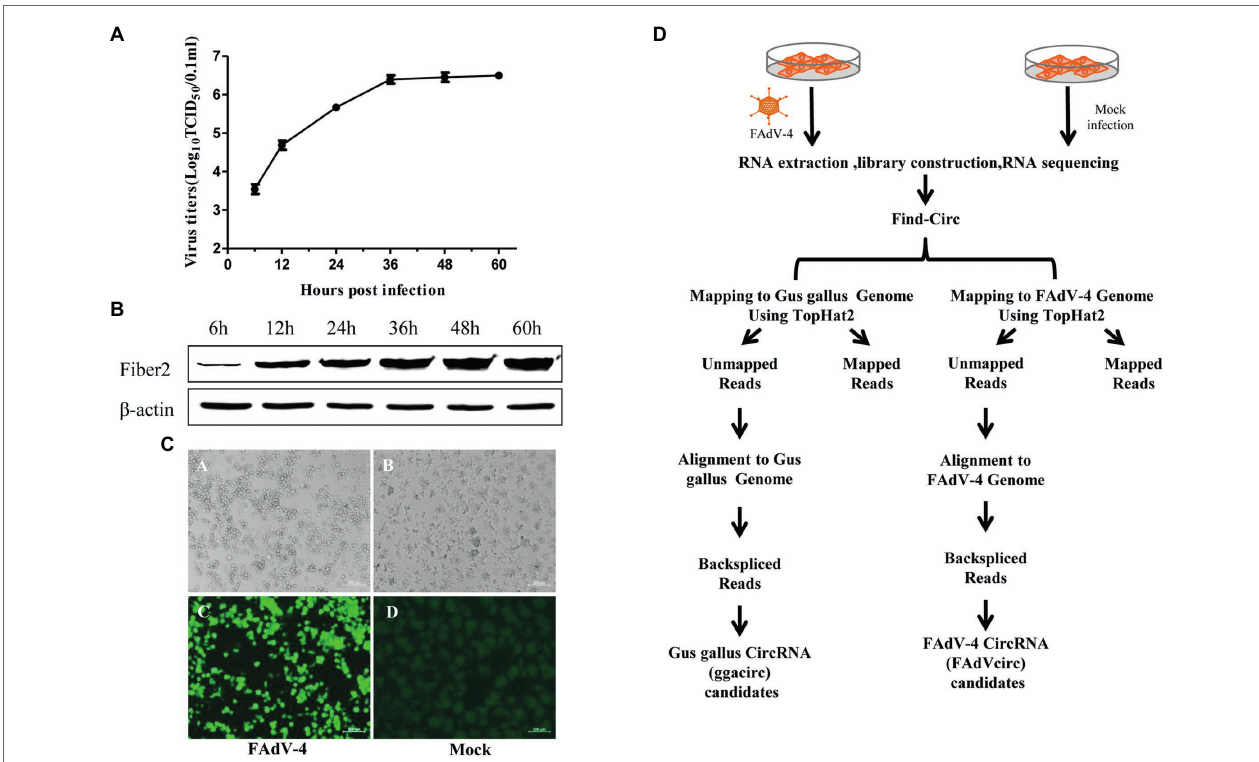
FIGURE 1 | Experimental schema for the identification of cellular and viral circRNA candidates in mock and FAdV-4 infected LMH cells and characterization of mock and FAdV-4 infected LMH cells. (A) LMH cells were infected with FAdV-4 at a MOI of 0.1; viral supernatants collected from infected LMH cells at the indicated time points were then titrated by TCID 50 . (B) Analysis the expression of Fiber2 protein in LMH cells infected with FAdV-4 at different times. (C) FAdV-4 induced cytopathic effect in LMH cells at 36 h and the IFA result. (D) Flowchart demonstrates how the high-throughput sequencing data were analyzed and how cellular and viral circRNAs were identified.